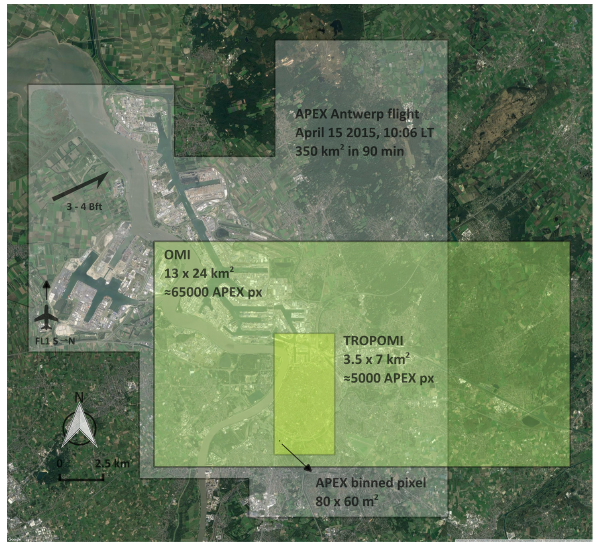
Figure 2. Details of the APEX flight plan over Antwerp on 15 April 2015 and comparison with a space-borne nadir OMI and TROPOMI pixel (Google, DigitalGlobe). Table 1. APEX spatial performance and instrumental specifications. Spatial performance (at 6100ma.g.l.) Spatial CCD 1000